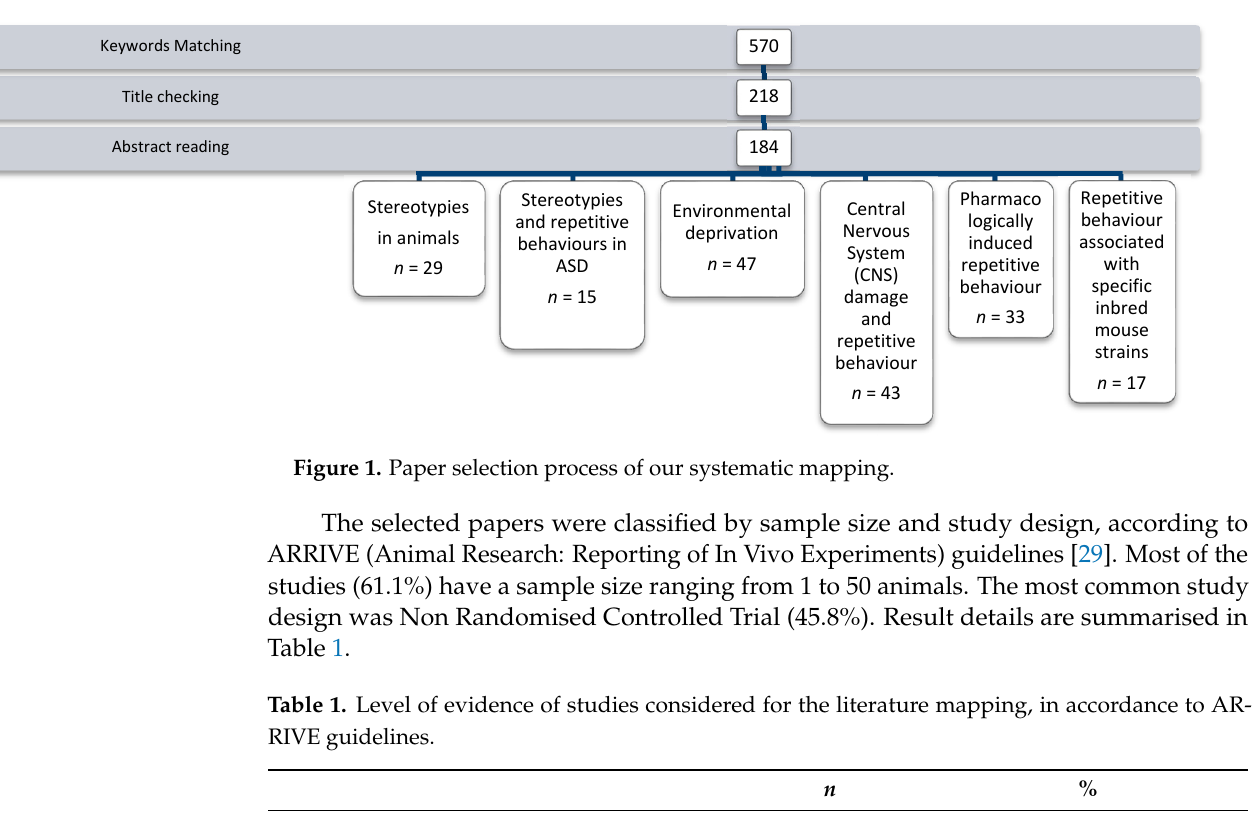
Table 1. Level of evidence of studies considered for the literature mapping, in accordance to AR- RIVE guidelines.